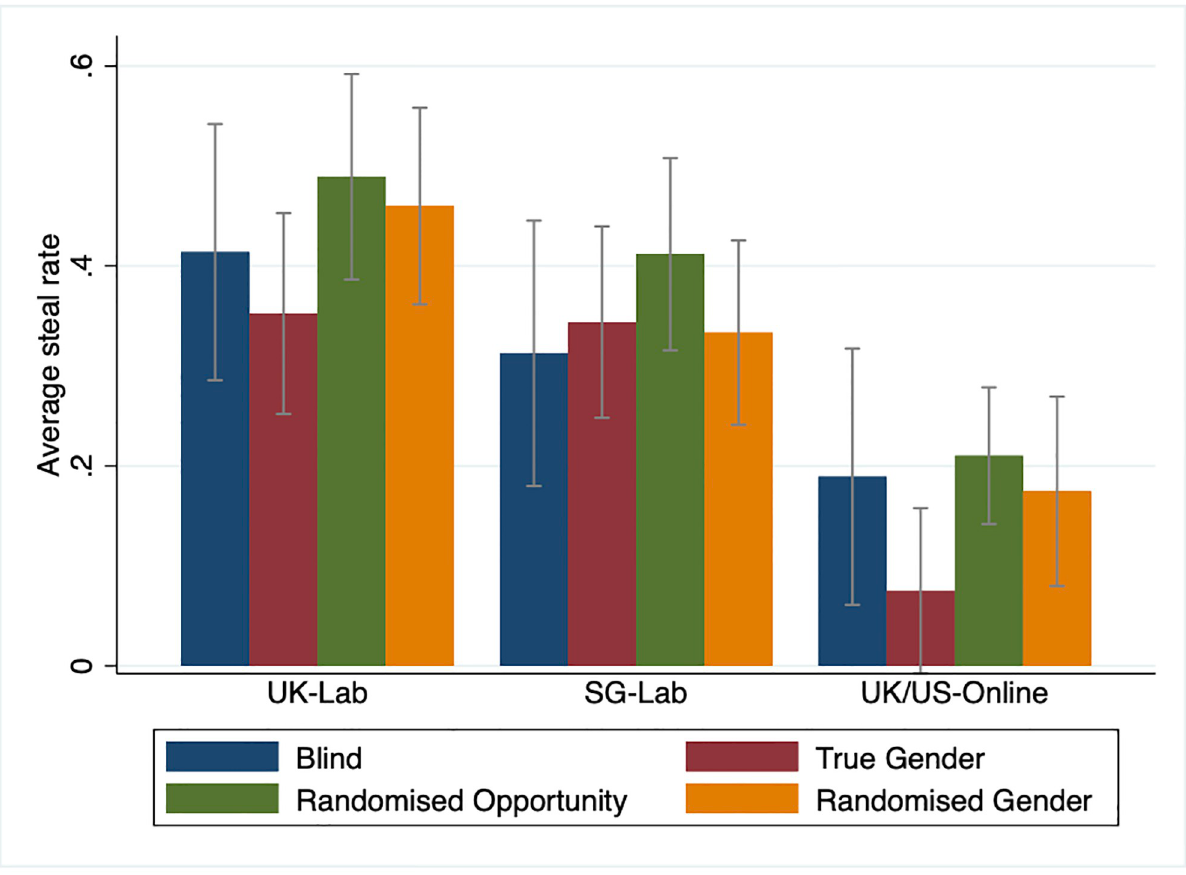
Fig 4. Average steal rates in the Golden Balls game by treatment and location. See Fig 2. Error bars represent 95% confidence intervals.